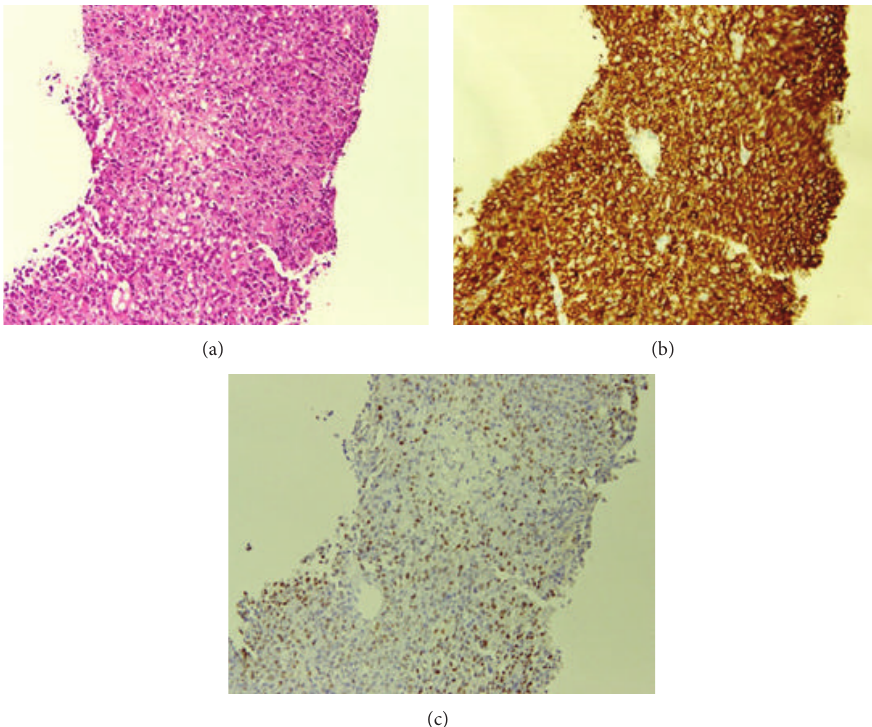
Figure 2: Histopathology of the liver biopsy shows (a) infiltration of medium-to-large lymphoid cells (hematoxylin and eosin, 100x), (b) CD20 positivity (100x), and (c) Epstein-Barr virus-encoded small RNA positivity (100x).